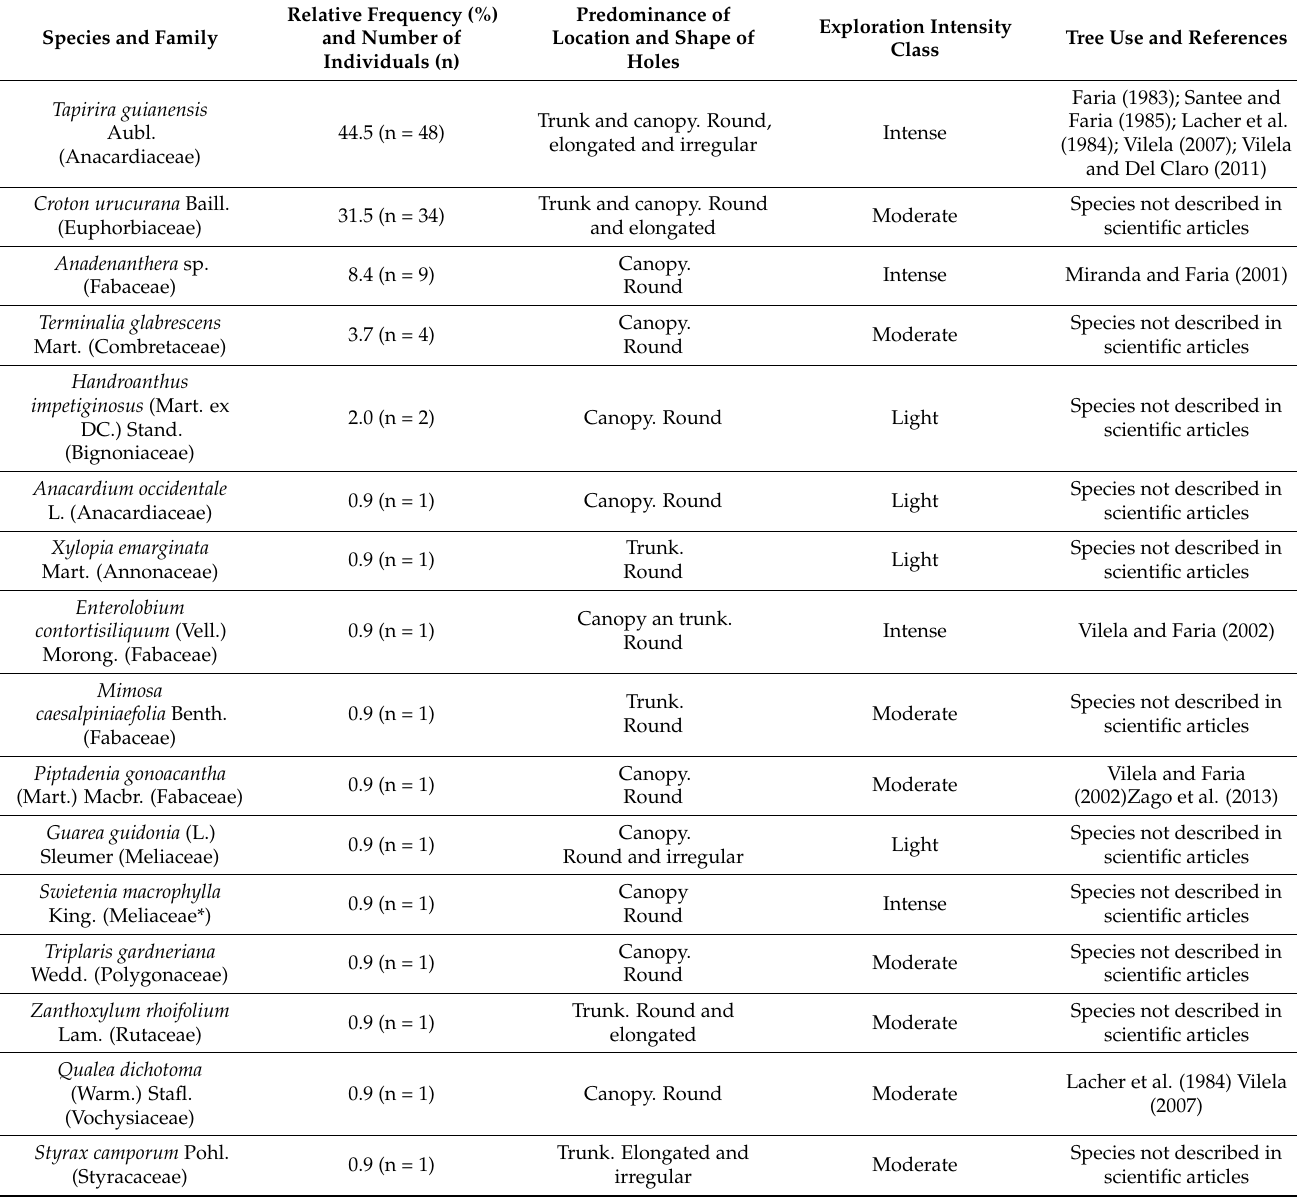
Table 1. Tree species used by black-tufted marmosets ( Callithrix penicillata ) to obtain exudates in urban forest fragments in municipality of Goi â nia, GO, Brazil. In the columns are the species, botanical families, the relative frequency, exploration characteristics, and known species, with the source in the literature. The list is arranged in descending order of relative frequency. Two unidentified species were removed from the sample. Total of individuals = 108. Trees from Anacardiaceae and Euphorbiacea families had the highest relative abundance (45.4% and 31.5%,